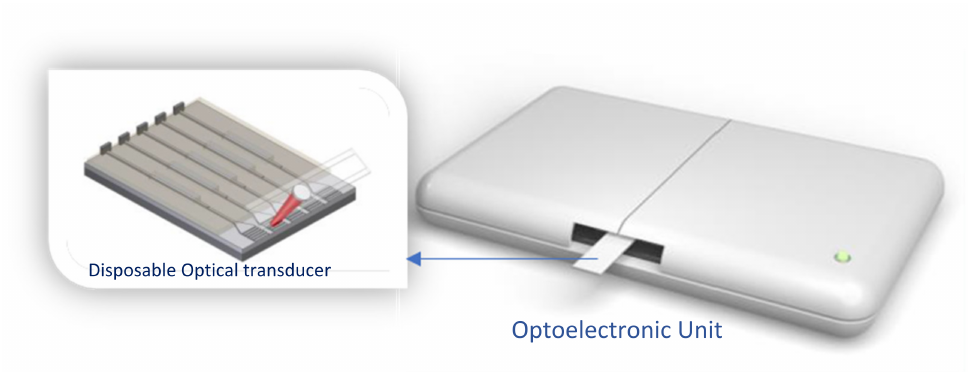
Figure 11. Illustration of the optoelectronic unit and a very ample view of the disposable optical bimodal waveguide (BiMW) interferometric technology considered in the CONVAT project. Made by the author based on material courtesy of Laura Lechuga